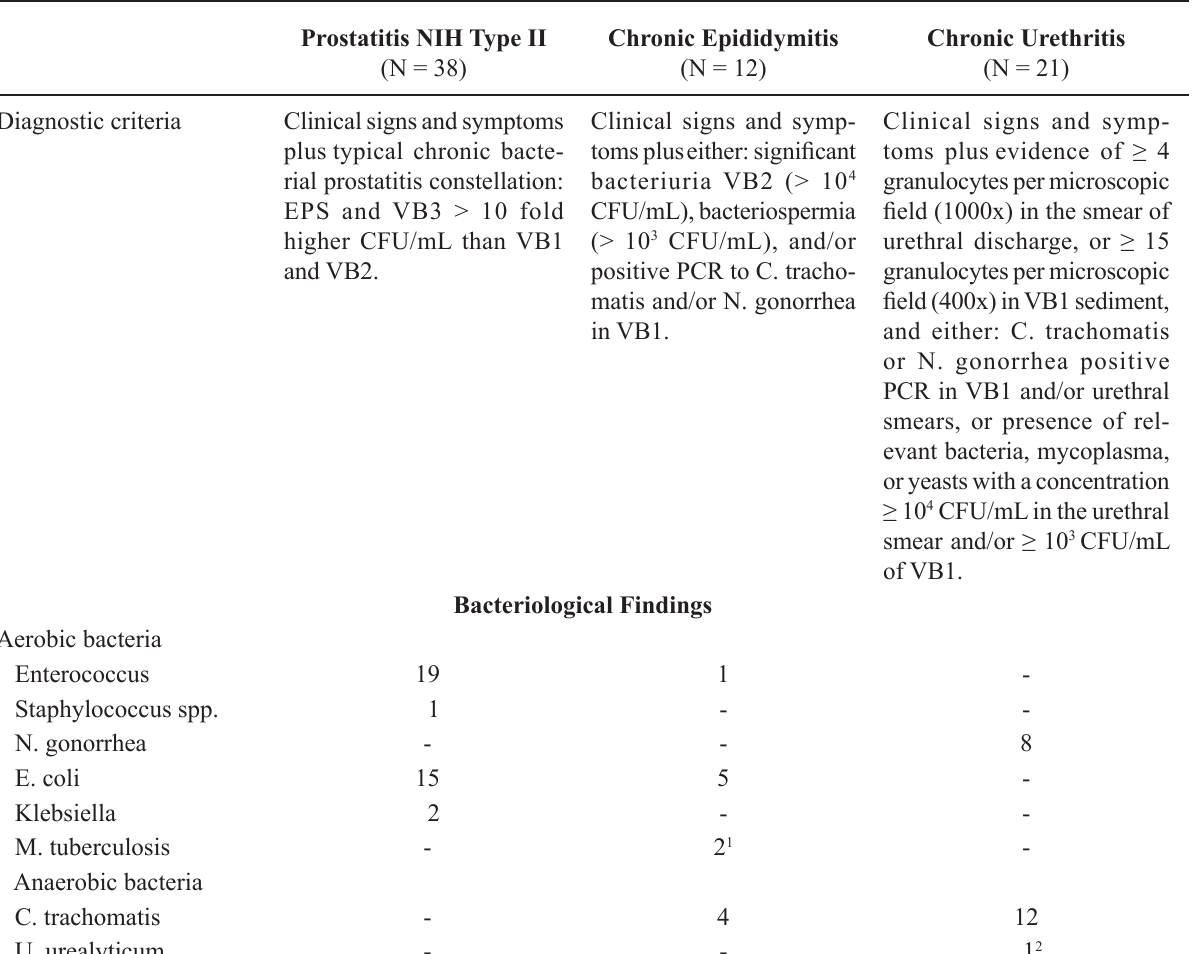
Table 1 – Laboratory criteria used for categorization of the infectious diseases of the male reproductive tract and bacte- riological findings of all